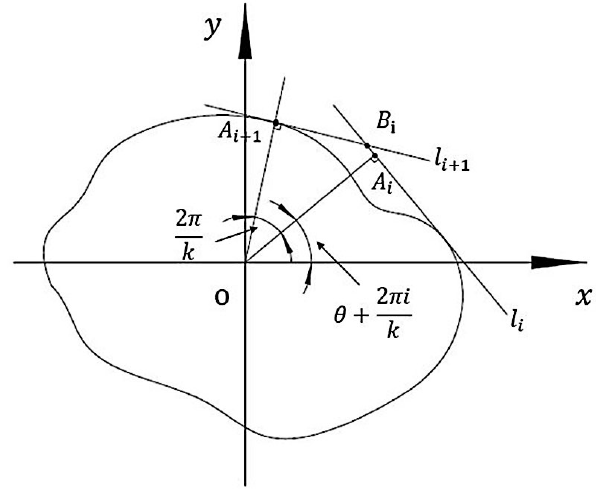
Figure 1. Schematic diagram of the contact of the lapping tool with the external surface of the workpiece.